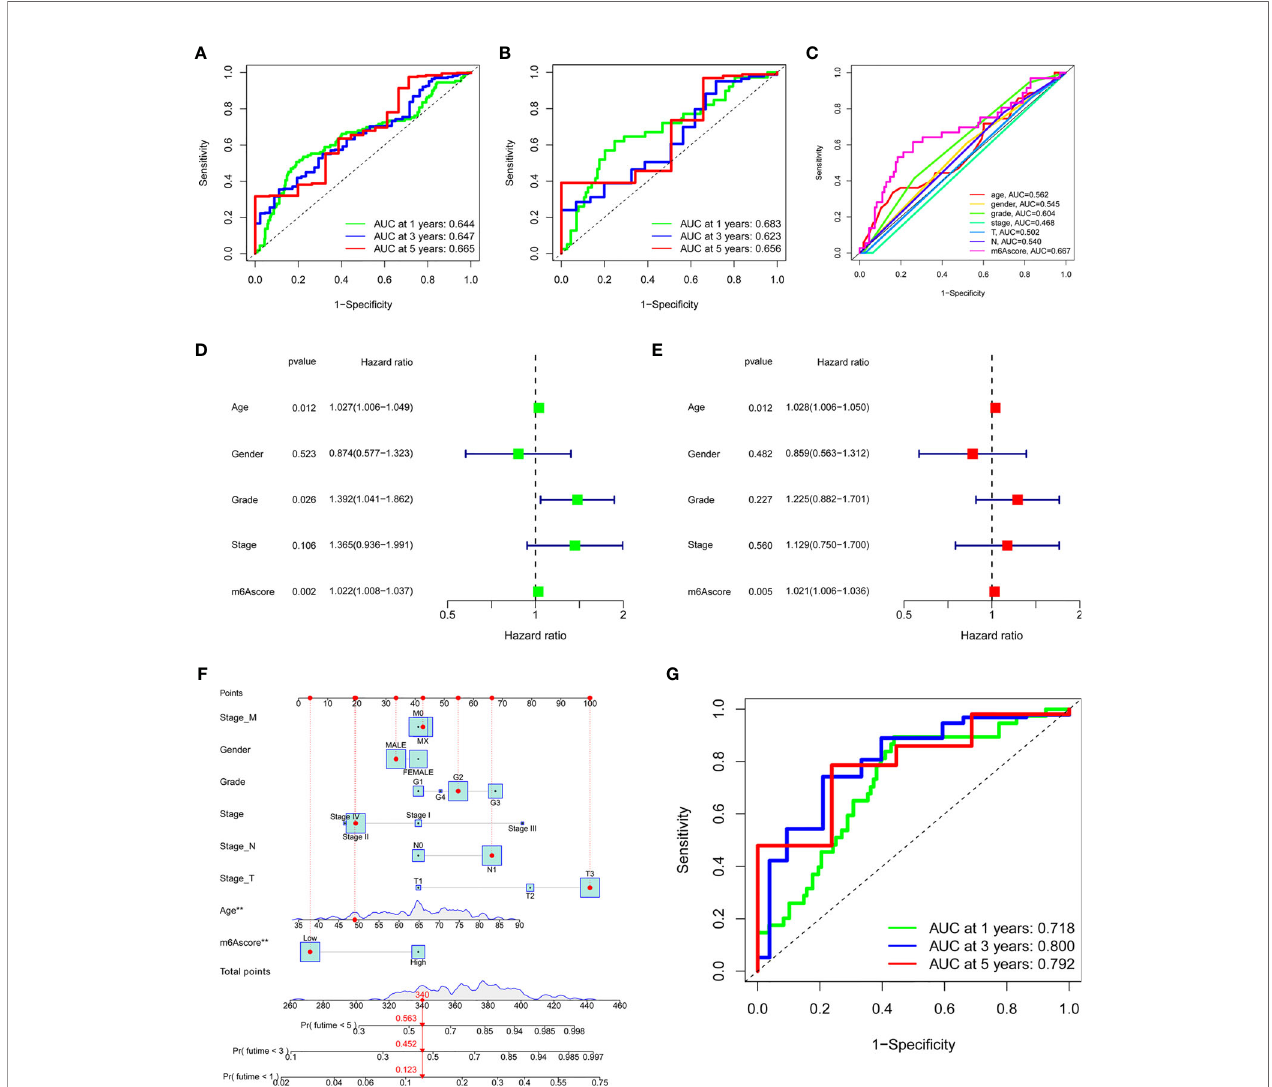
FIGURE 5 | Validation and application of the m 6 A score in the clinical evaluation. (A) The AUC values of the 1-year, 3-year, and 5-year ROC curves of m 6 A score in all samples. (B) The AUC values of the 1-year, 3-year, and 5-year ROC curves of m 6 A score in the TCGA-PAAD cohort. (C) The comparation of 1-year ROC curve with other clinical characteristics in the TCGA-PAAD cohort. (D) Univariate COX regression analysis showed that age, grade, and m 6 A score were considered statistically signi fi cant. (E) Multivariate Cox regression analysis showed age and m 6 A score were independent prognostic predictors. (F) The nomogram to predict the probability of 1-year, 3-year, and 5-year survival rate. (G) The AUC values of the 1-year, 3-year, and 5-year ROC curves of the nomogram. ***P < 0.001; **P < 0.01; *P <